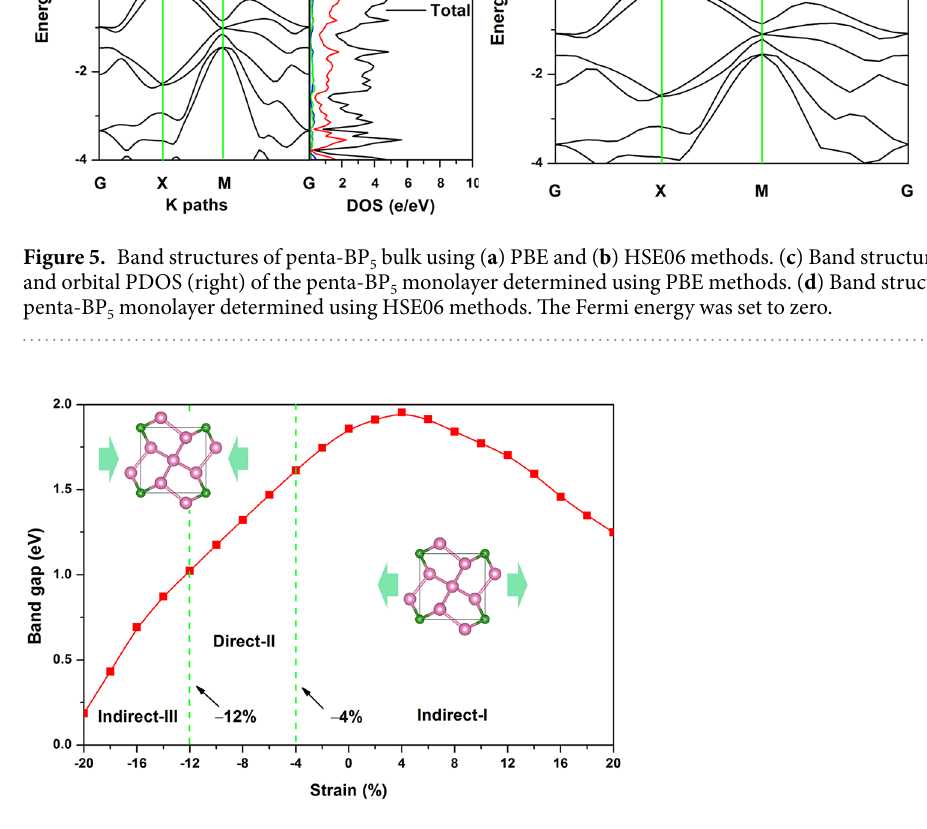
Figure 6. Variation of band gap with in-plane uniaxial strain for the penta-BP 5 monolayer using the PBE method. The inset shows the direction of